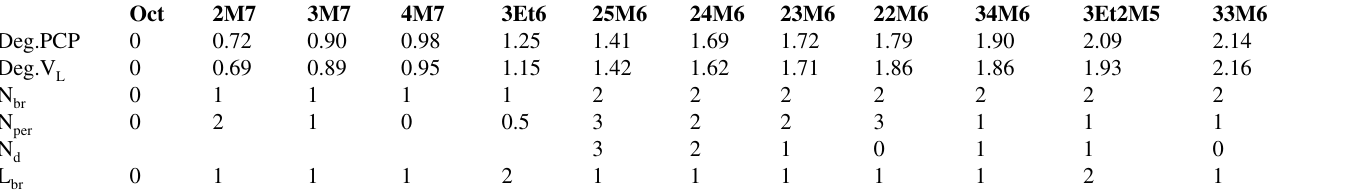
Table 1. Branching degrees of octane isomers derived from the normalized data of the physicochemical properties of octanes as well as the measures of structural